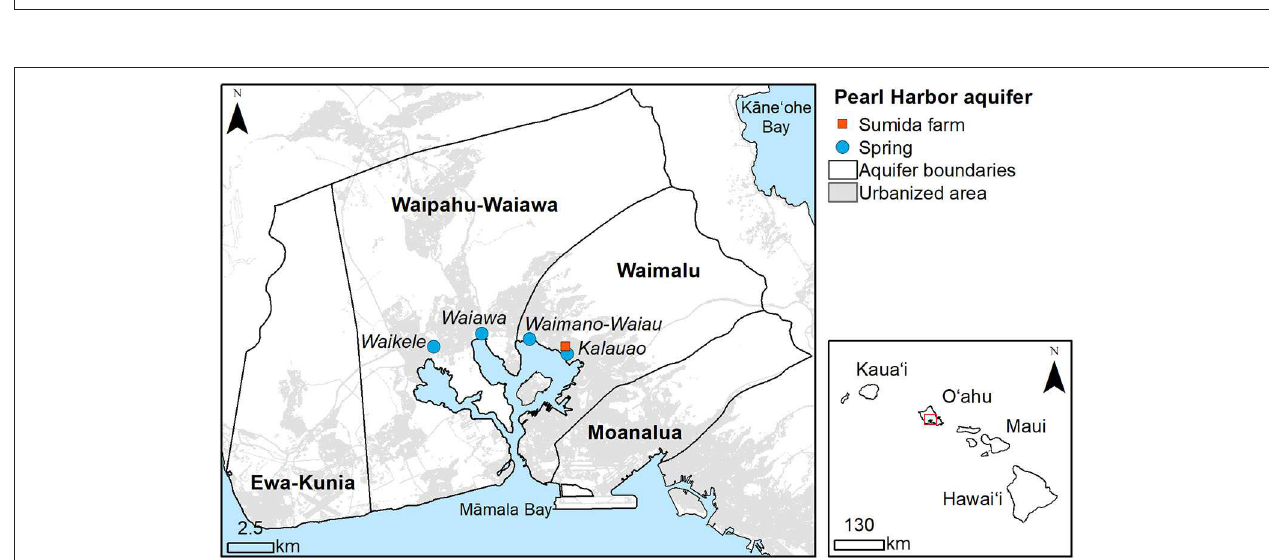
FIGURE 2 | Study area. The location of four (sub-) aquifer units (Ewa-Kunia, Waipahu-Waiawa, Waimalu, and Moanalua), Sumida Farm (within Kalauao spring complex) and other coastal springs situated in the Pearl Harbor aquifer of